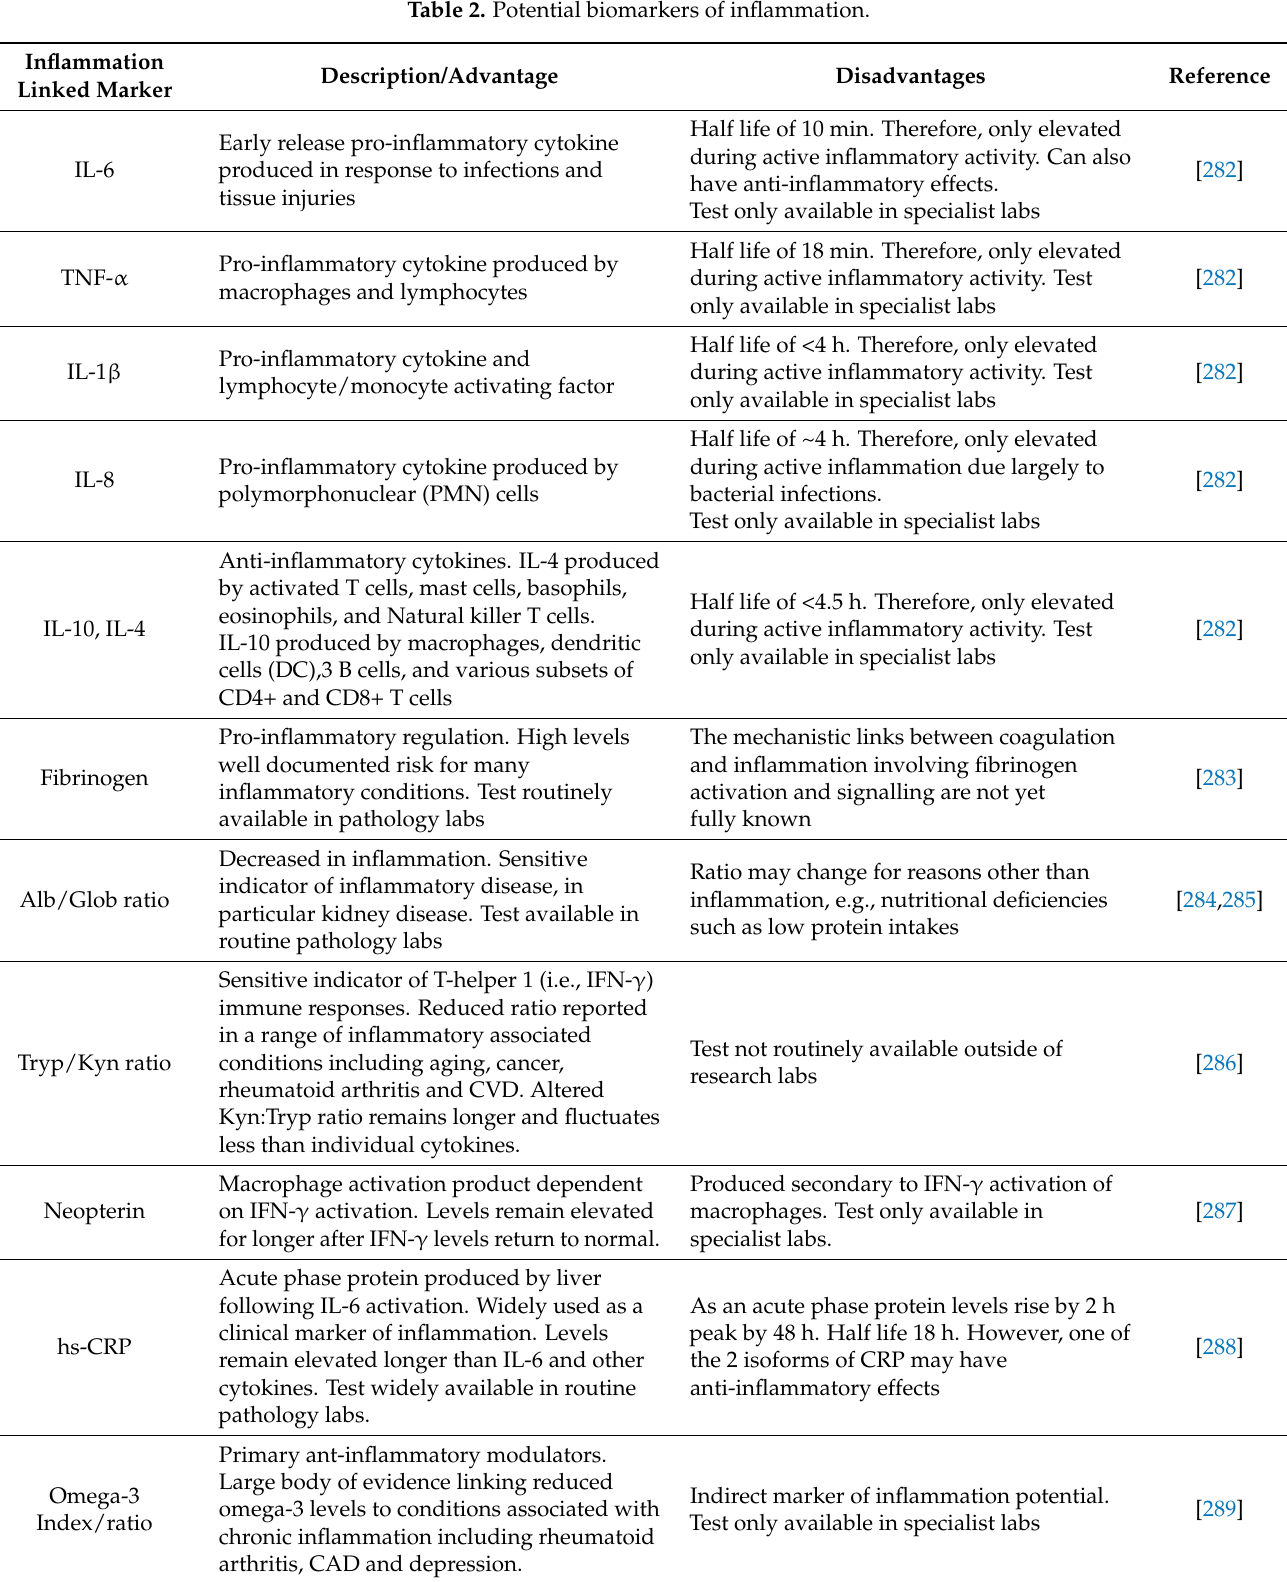
Table 2. Potential biomarkers of